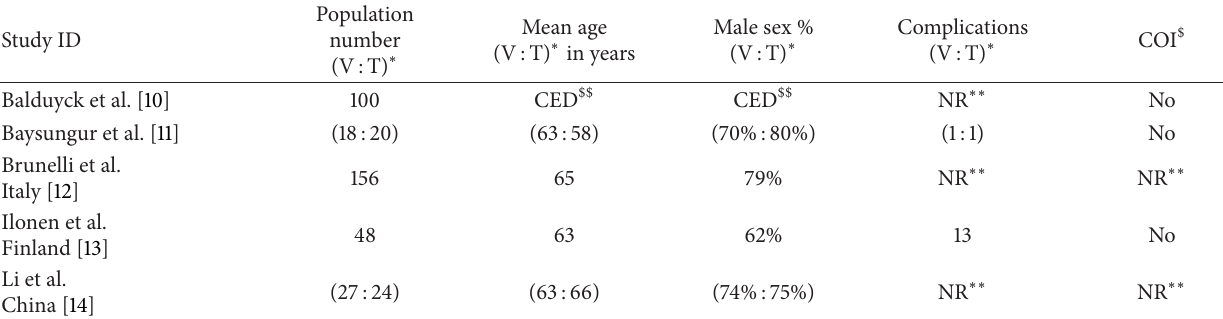
Table 3: Summary of study characteristics (cont.).